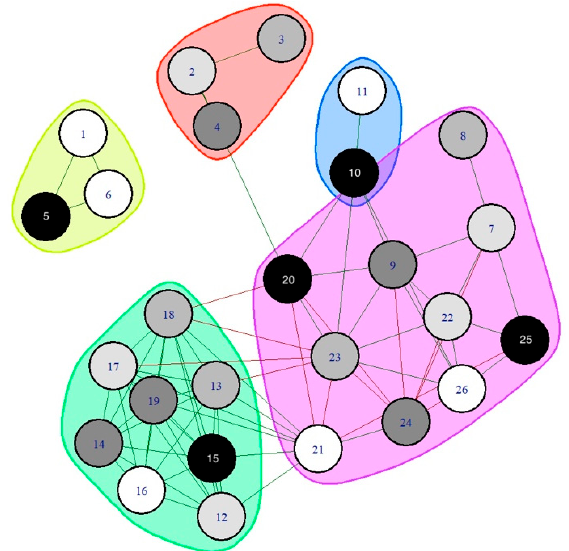
Figure 7. Clusters identified by the Louvain community detection algorithm. Green cluster: psycho- physical (PPTs) variables; purple cluster: pain-related, cognitive, health-related, and physical vari- ables; blue cluster: pain extent variables; red cluster: sociodemographic variables; yellow cluster: diagnostic variables. Numbers represent the same nodes reported in Figure 2.